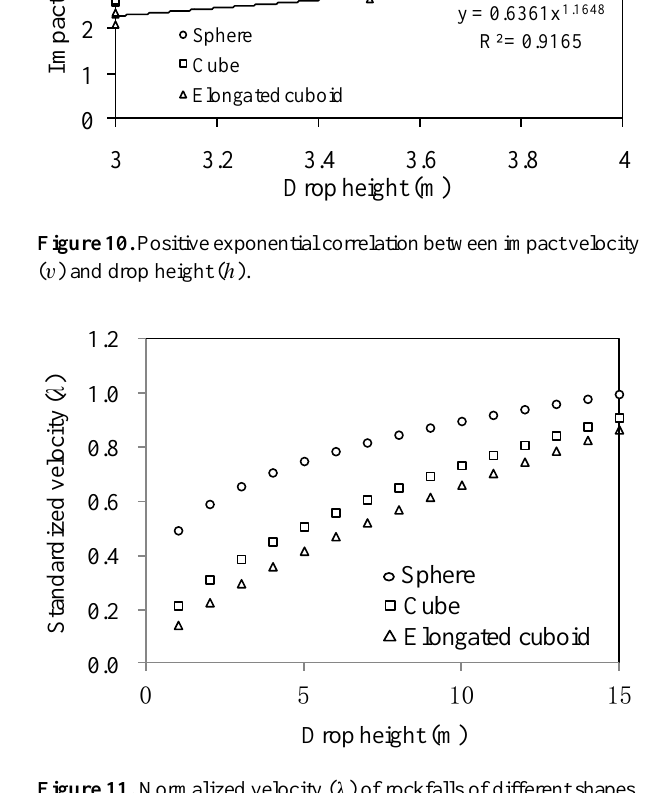
Figure 11. Normalized velocity ( λ ) of rockfalls of different